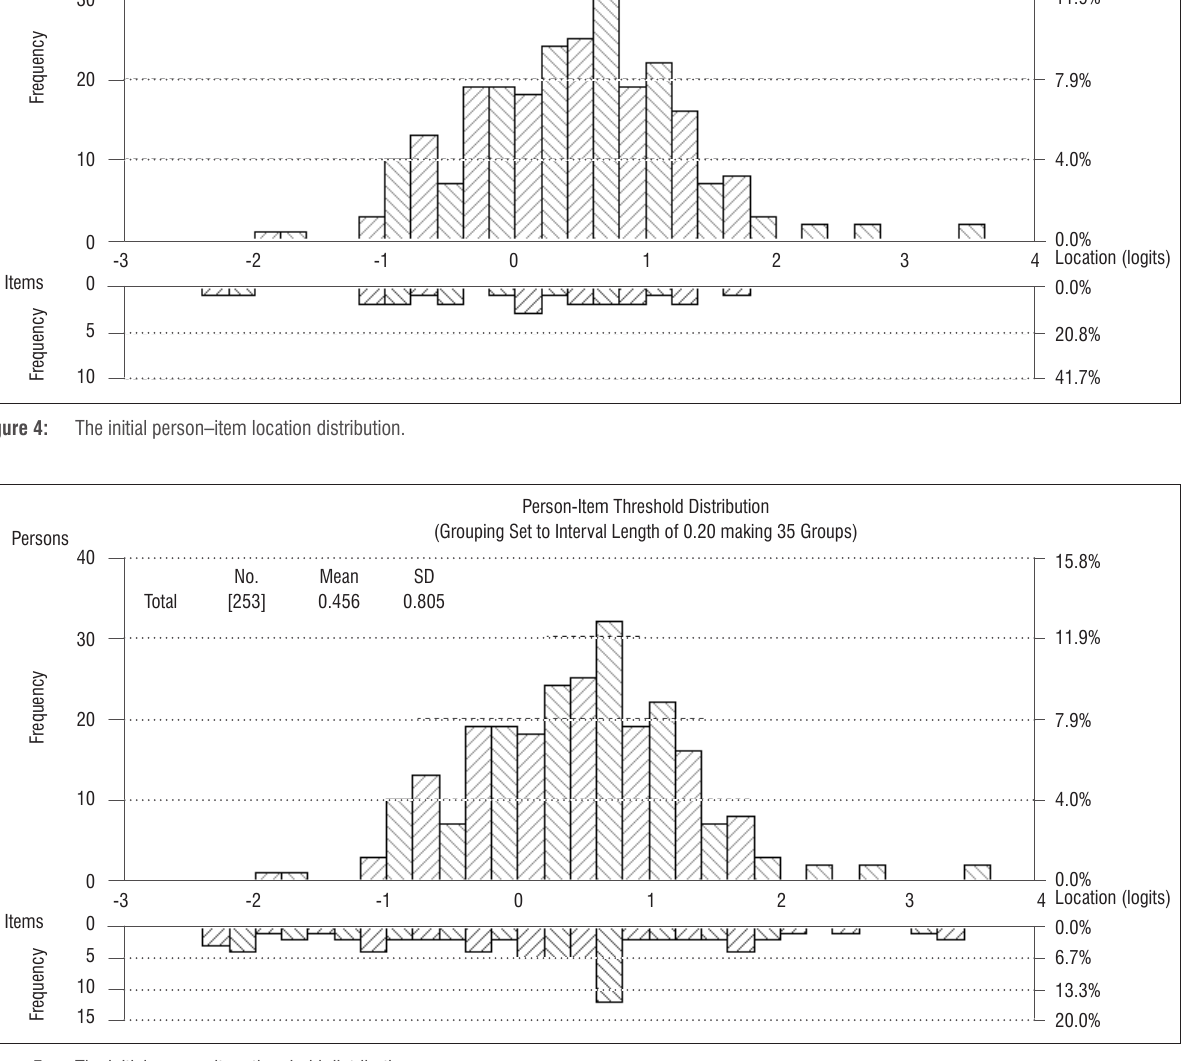
Figure 5: The initial person–item threshold distribution.